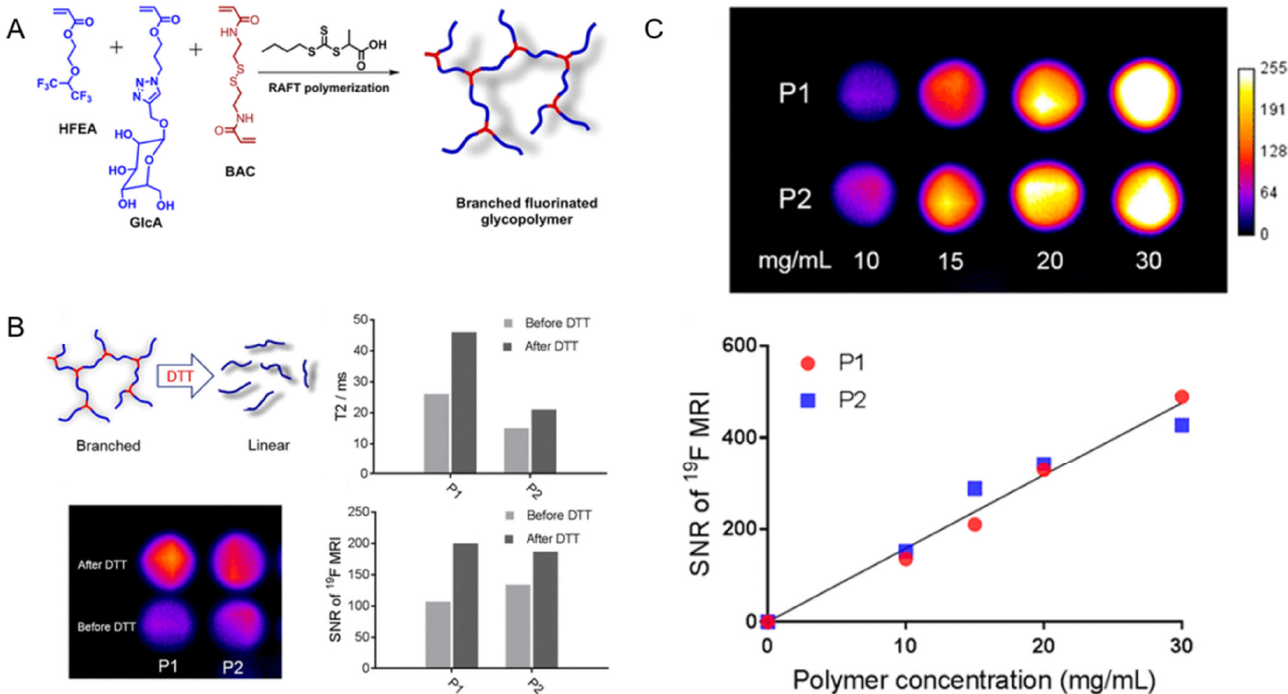
Figure 2. ( A ): Synthesis of branched fluorinated glycopolymers by a one-pot RAFT Polymerization. ( B ): (Upper left) the transformation of a branched structure to a linear structure when the polymer is exposed to high levels of DTT; (Upper right) a comparison of the T 2 relaxation time of P1 and P2 before and after treatment with 10 mM DTT; (Lower left) a comparison of 19 F-MRI images of P1 and P2 solutions before and after 10 mM DTT treatment; (Lower right) the signal-to-noise ratio of 19 F-MRI of P1 and P2 solutions before and after 10 mM DTT treatment. ( C ): (Upper) the 19 F-MRI of P1 and P2 solutions; (Lower) the 19 F-MRI signal-to-noise ratio of P1 and P2 solutions within a certain concentration range [61]. Reproduced with permission from American Chemical Society 2019.